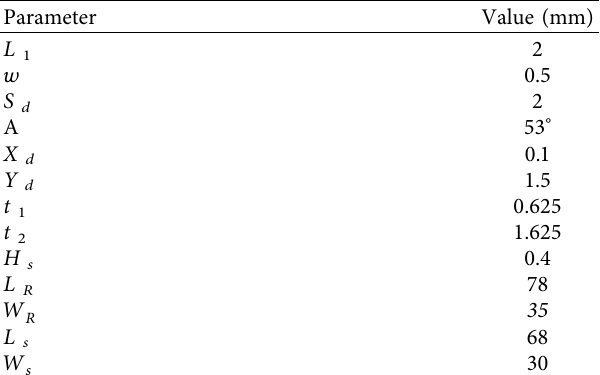
Table 1: Parameter list of the proposed CP antenna